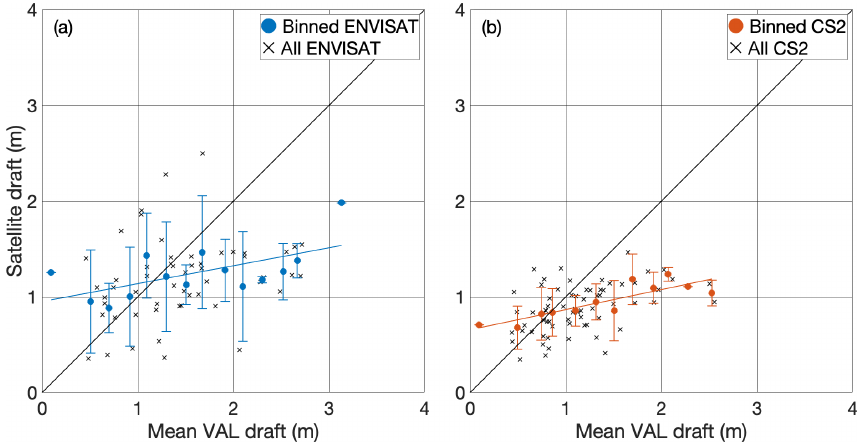
Figure 4. Scatter plot comparing gridded monthly mean CCI-2 sea ice draft to VAL sea ice draft (black crosses). Panel (a) shows the comparison for the ENVISAT period superimposed by the mean ENVISAT draft per 0.2m VAL data bin, while panel (b) shows the same for the CS2 data and period. Error bars indicate ± 1 standard deviation of the CCI-2 data within the specific 0.2m bin.